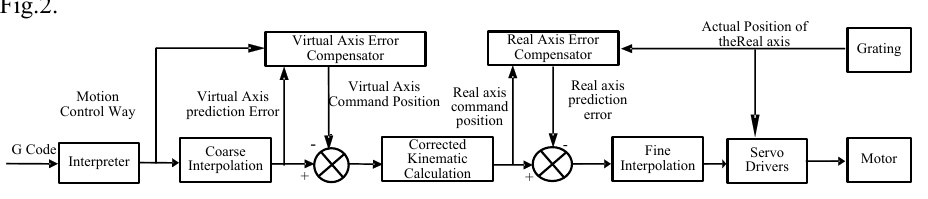
Fig. 2. Virtual - real double axis error compensation system